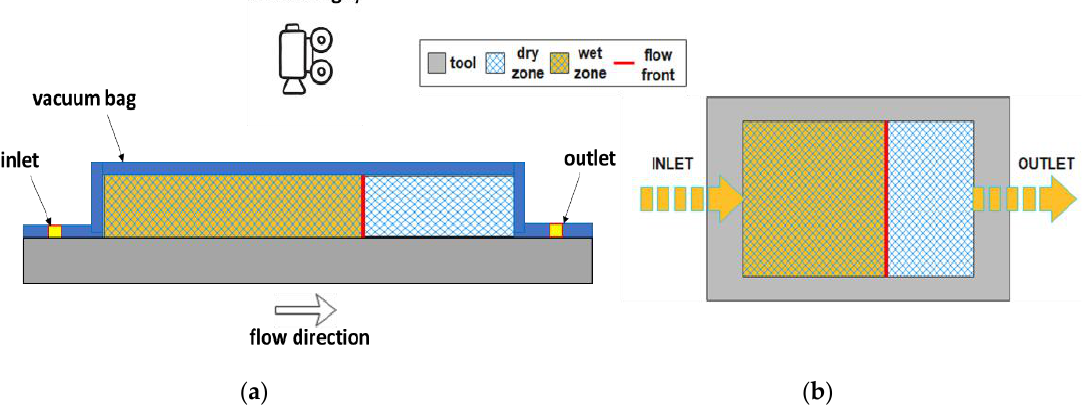
Figure 5. ( a ) Experimental set-up for video recording method and ( b ) a sketch of in-plane flow front